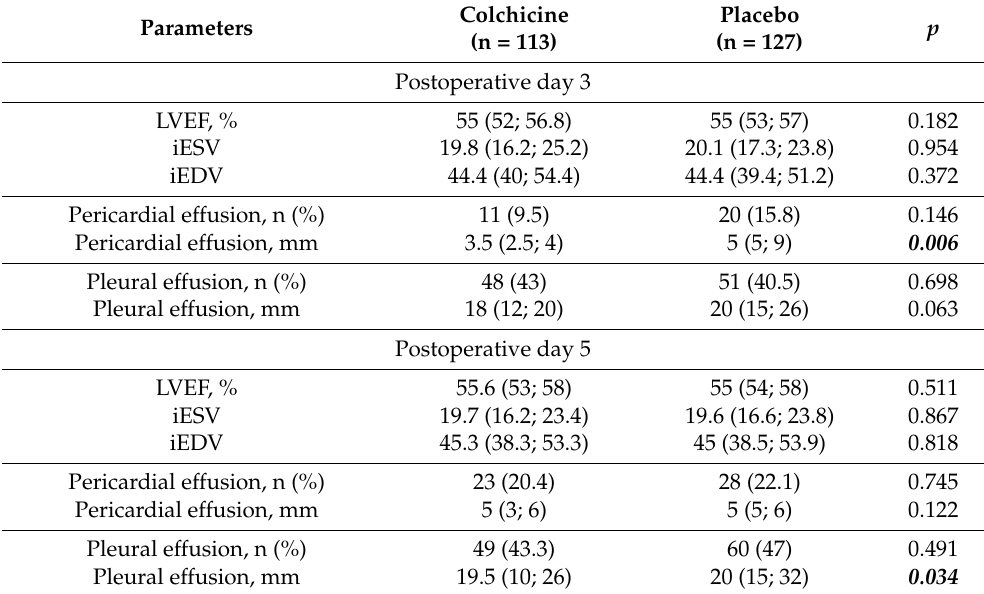
Table 5. Postoperative echocardiographic parameters.